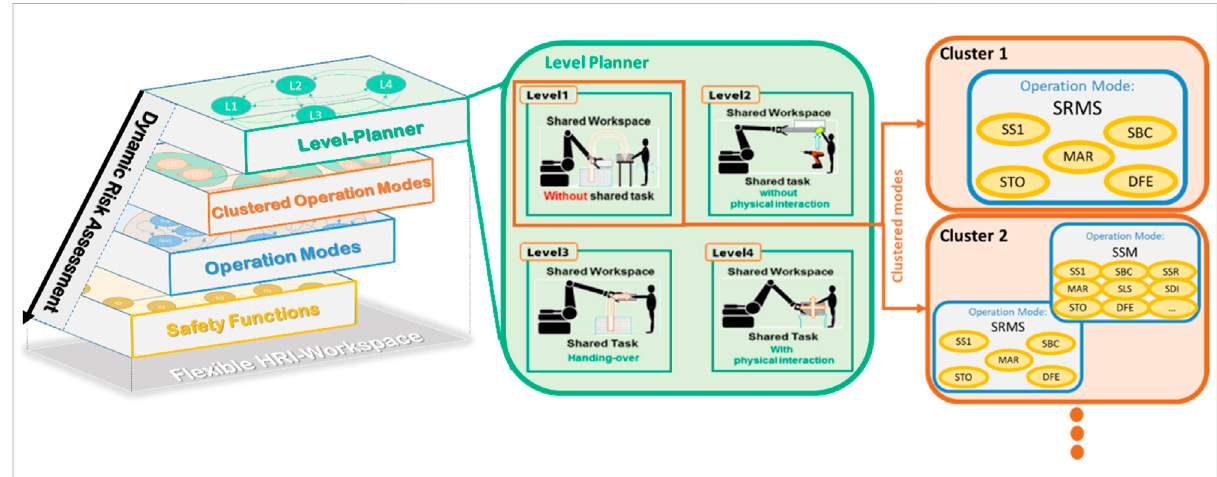
Example of the possible collaborative operation mode clusters of level 1 with their safety